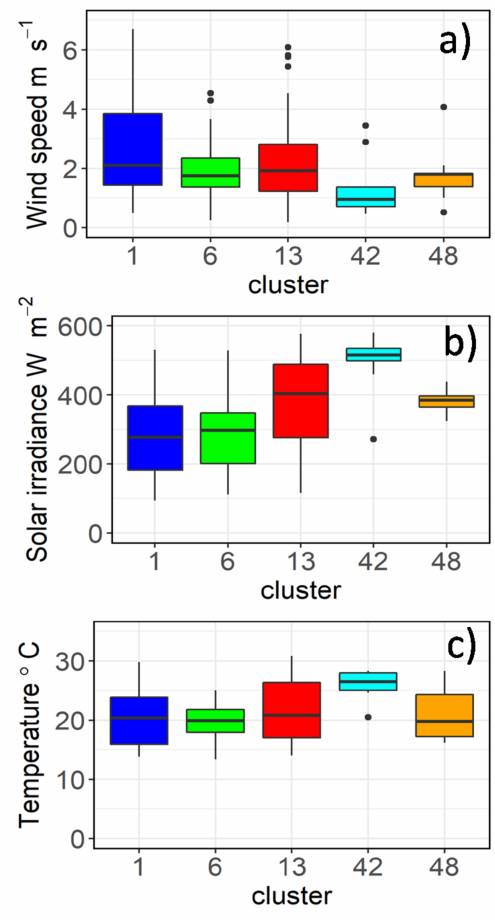
Figure 6. Boxplots of environmental parameters ( a ) wind speed, ( b ) solar irradiance and ( c ) air temperature for the different clusters.